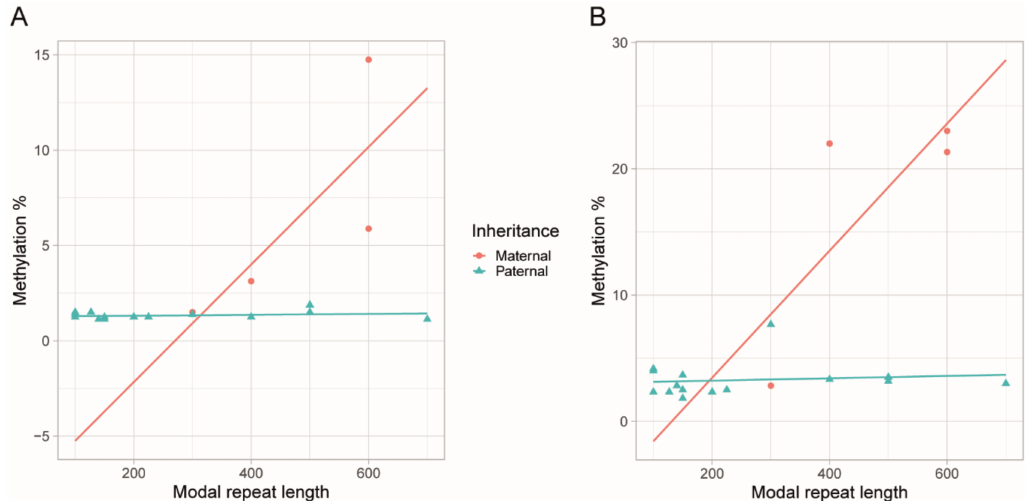
Figure 3. The scatter plots with regression lines show the relationship between the modal repeat size and the methylation levels of the CpG sites of the patients for whom we knew the parental origin of the disease allele. For neither the upstream ( A ) nor downstream ( B ) CpG sites there was a correlation between the modal repeat length and the methylation levels in the patients who had inherited the disease paternally. As the number of the patients who had inherited the maternal disease allele was too low ( n = 4), it was not possible to make a confident statistical